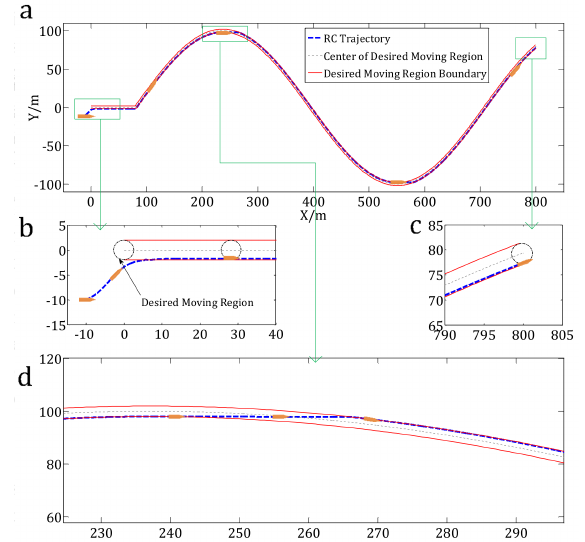
Figure 4. Results of the traditional RC method. ( a ) Trajectory of the USV using the traditional RC method; ( b ) Zoom view of the results from − 10 to 40 m in the X direction; ( c ) Zoom view of the results from 790 to 805 m in the X direction; ( d ) Zoom view of the results from 225 to 298 m in the X direction.